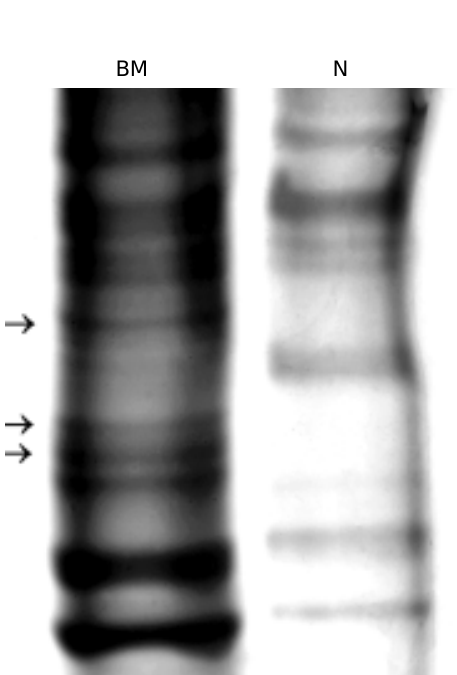
Figure 1. Alterations in the elec- trophoretic pattern observed in patient number 30, locus SE33. Arrows show shift or extra bands. BM = bone marrow; N =